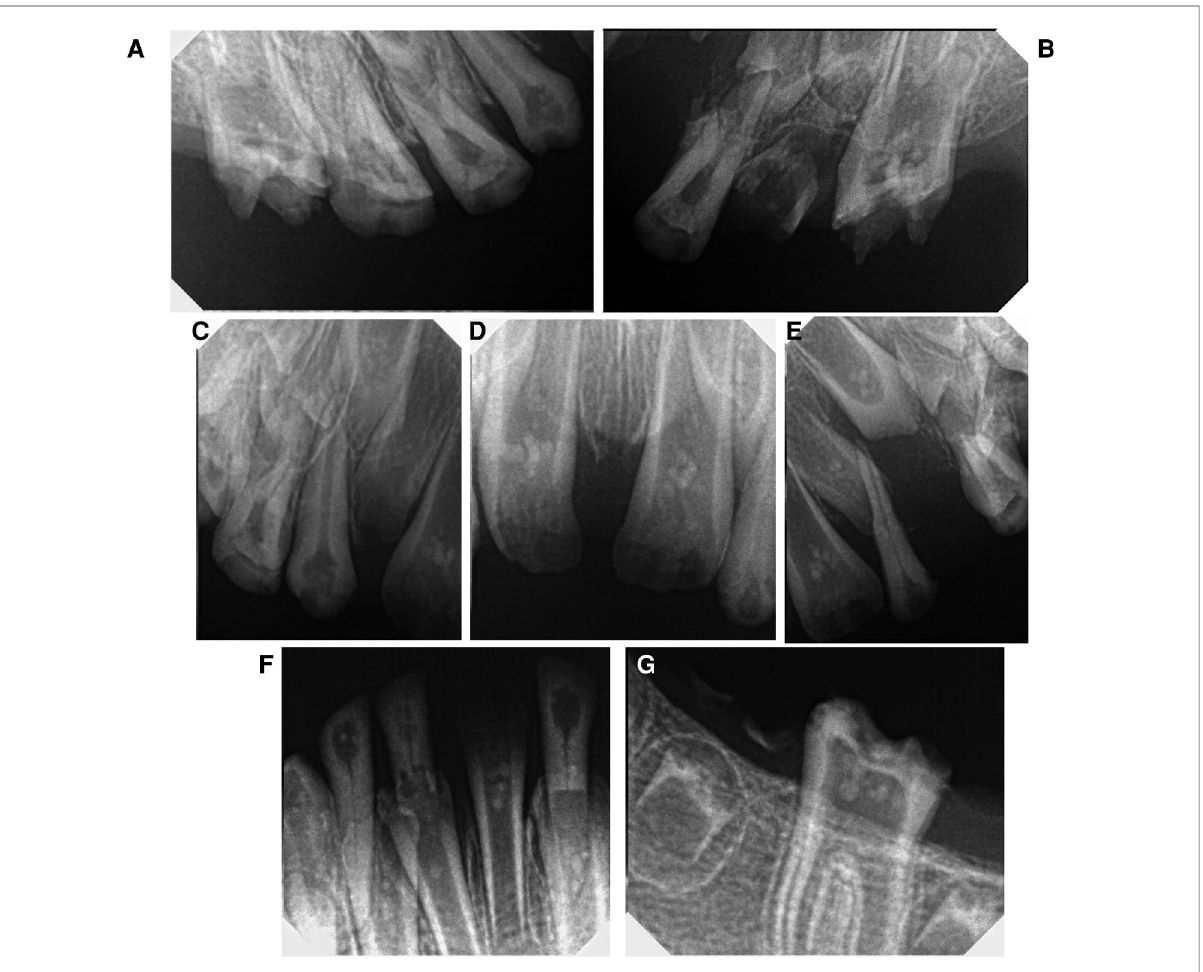
FIGURE 4 Periapical radiographs showing pulp calci fi cations. ( A ) Left maxillary, ( B ) right maxillary, ( C – E ) anterior maxillary region, ( F ) anterior mandibular, ( G ) right